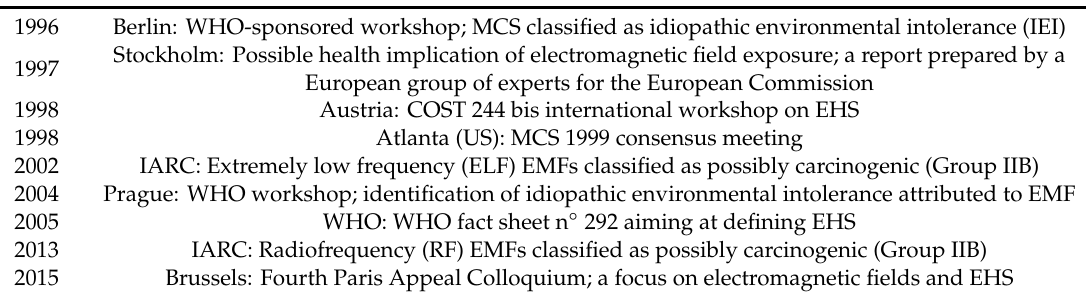
Brussels: Fourth Paris Appeal Colloquium; a focus on electromagnetic fields and